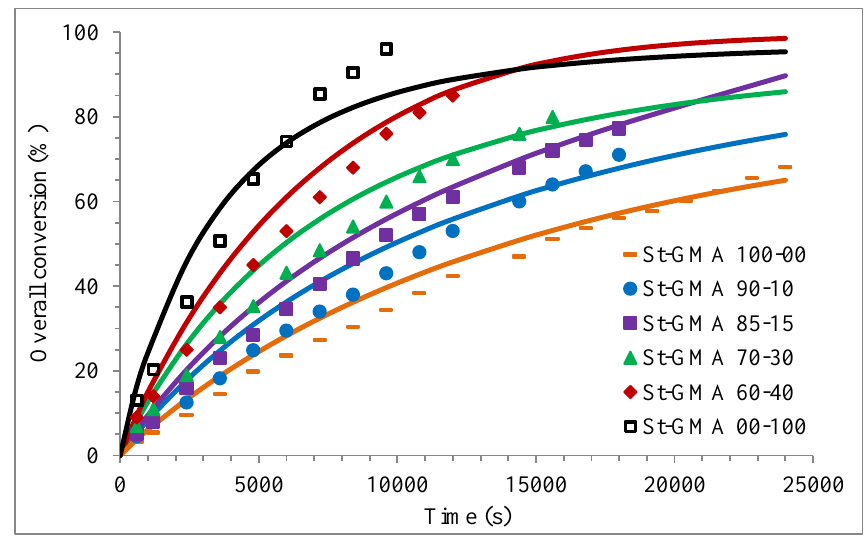
Figure 4. First-order of different St-GMA samples. Symbols represent experimental data, whereas solid lines correspond to model predictions.